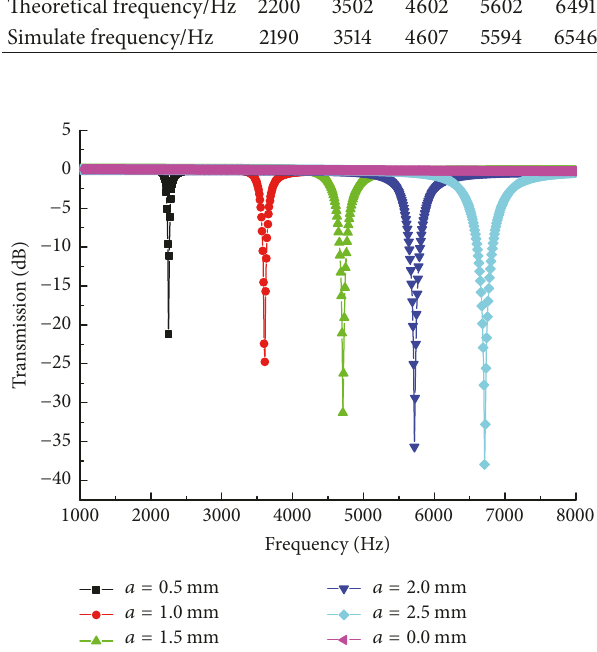
Figure 5: The transmission coefficients of Unit cell with different neck radius ( 𝑅 𝑜 = 5.0 mm, 𝑅 𝑖 = 4.5 mm).